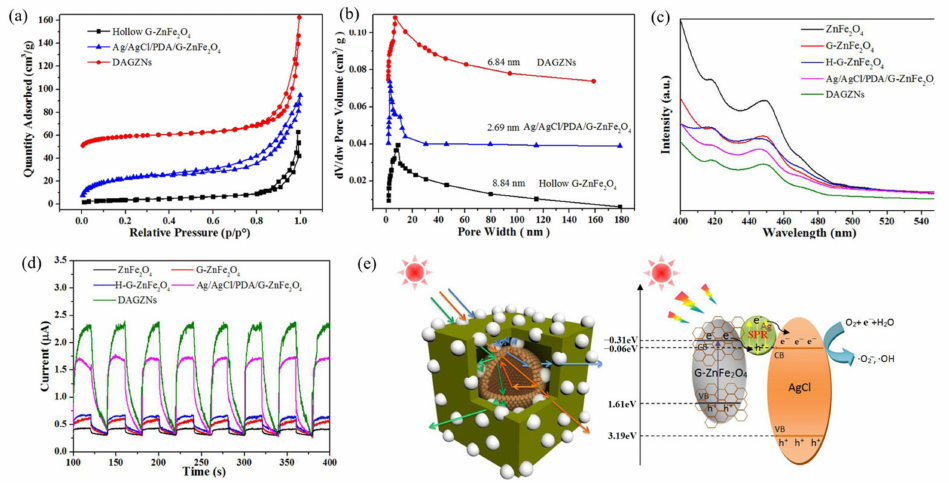
Figure 19. ( a ) The nitrogen adsorption–desorption isotherms of hollow G-ZnFe 2 O 4 , Ag/AgCl/PDA/G-ZnFe 2 O 4 , and DAGZNs; ( b ) Barrett–Joyner–Halenda (BJH) pore size distribution; ( c ) PL spectroscopy; ( d ) transient photocurrent; ( e ) schematic representation of the light